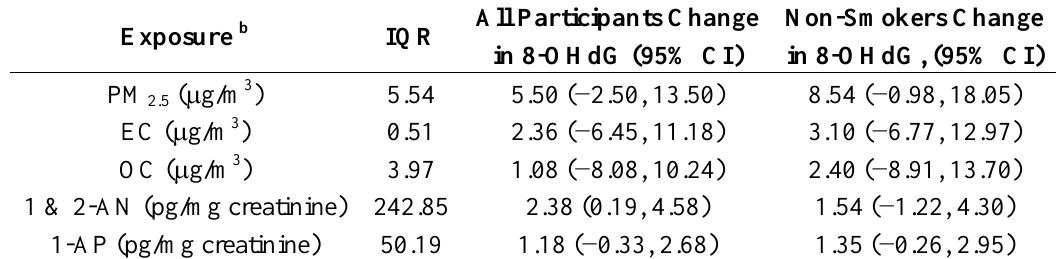
Table 3. Change in 8-OHdG levels (in µg/mg creatinine) and 95% confidence intervals associated with each IQR increase associated with air pollutants and biomarkers of exposure a